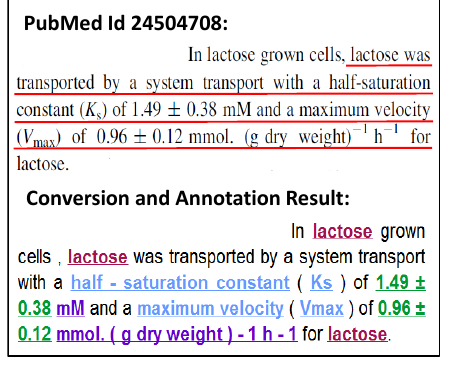
Figure 10: Comparison between original PDF and converted/annotated result showing a successful conversion and annotation.